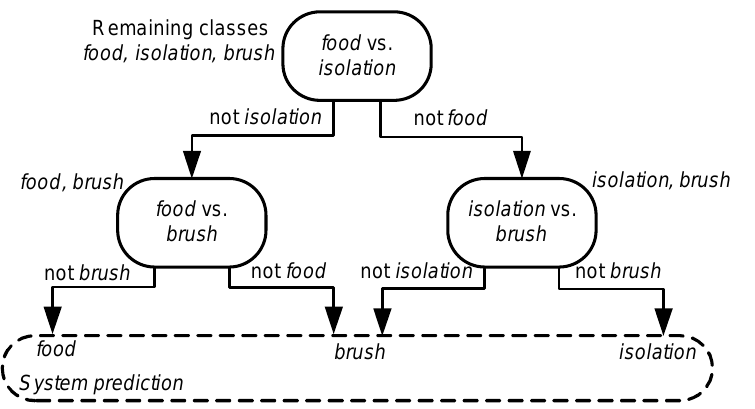
Figure 5. The DAG-HMM addressing the three-class problem of classifying cat manifestations. At each